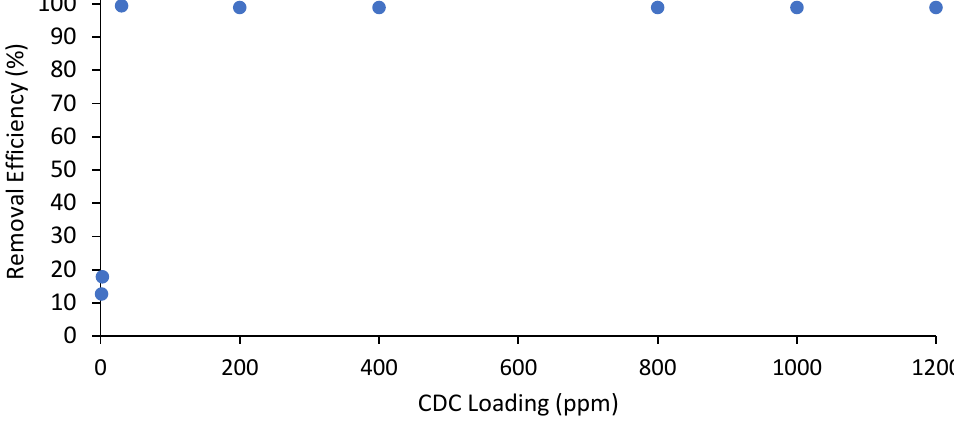
Figure 10. Mo removal efficiency of CDC vs. CDC loading (g/L): Mo concentration: 1 ppm; pH: 5.2; agitation speed: 150 RPM; adsorption time: 1 h.